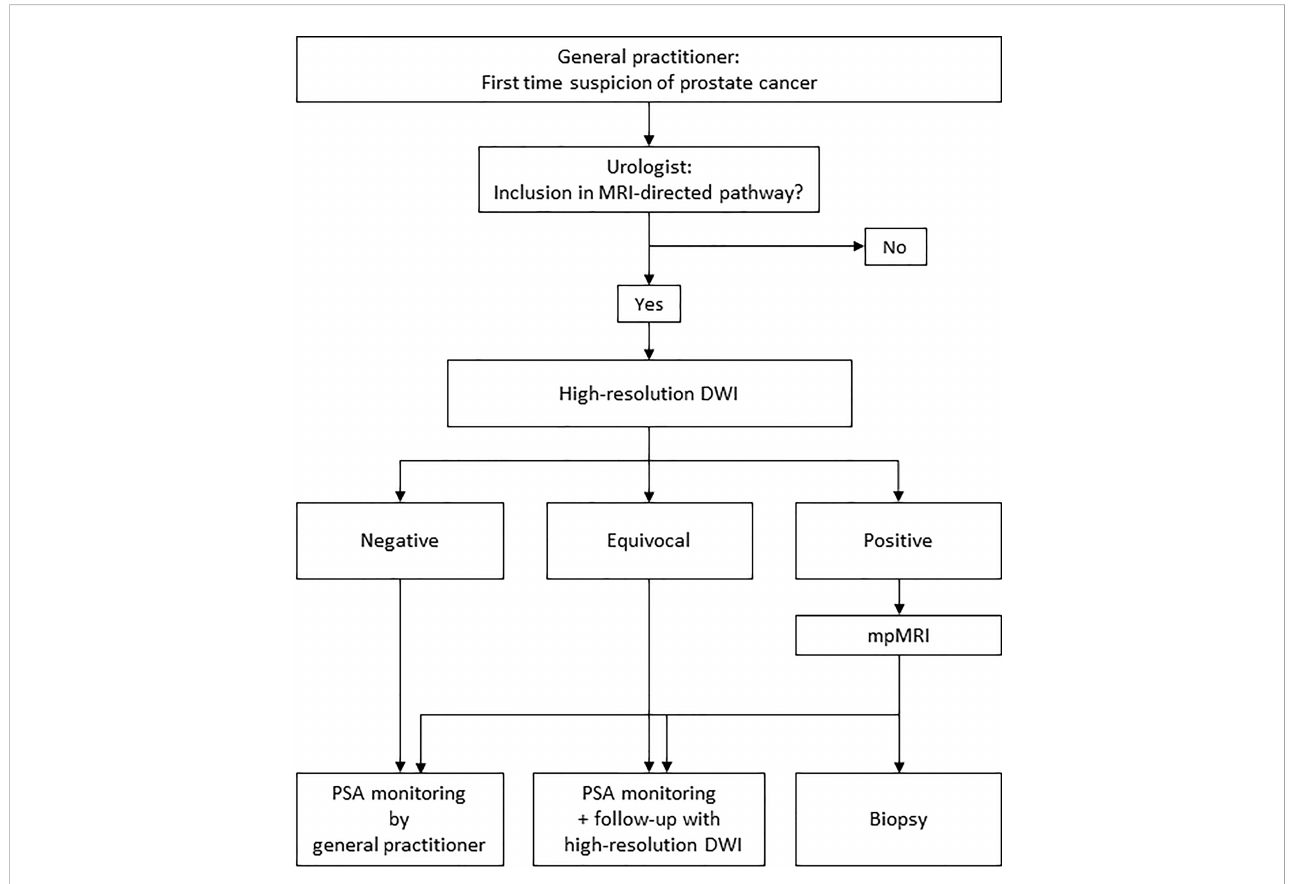
FIGURE 1 Illustration of the concept of an MRI-directed diagnostic pathway with high-resolution DWI-only as a fi rst step. In a clinical setting, clinical parameters are also taken into consideration before ruling out biopsy in MRI negative cases.